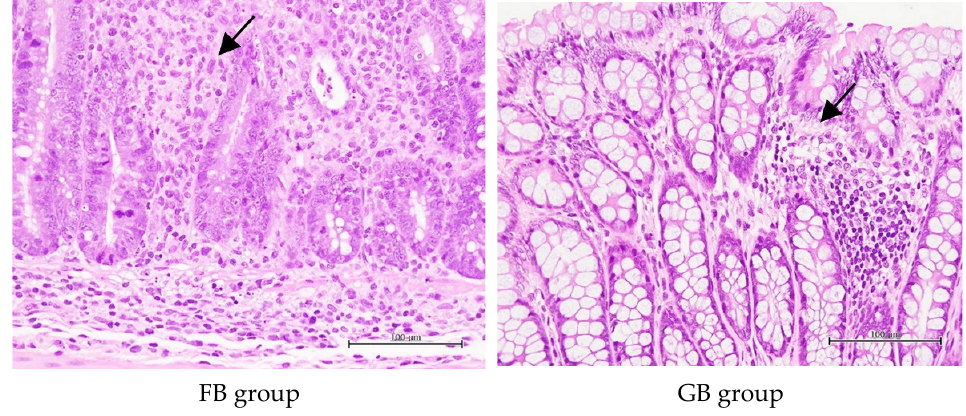
Figure 6. Representative H&E stained colon tissues among different animal groups. The black arrowheads indicate that submucosae were infiltrated with inflammatory cells. Table 3. Histopathological scoring of inflammation grading based on H&E staining in different animal